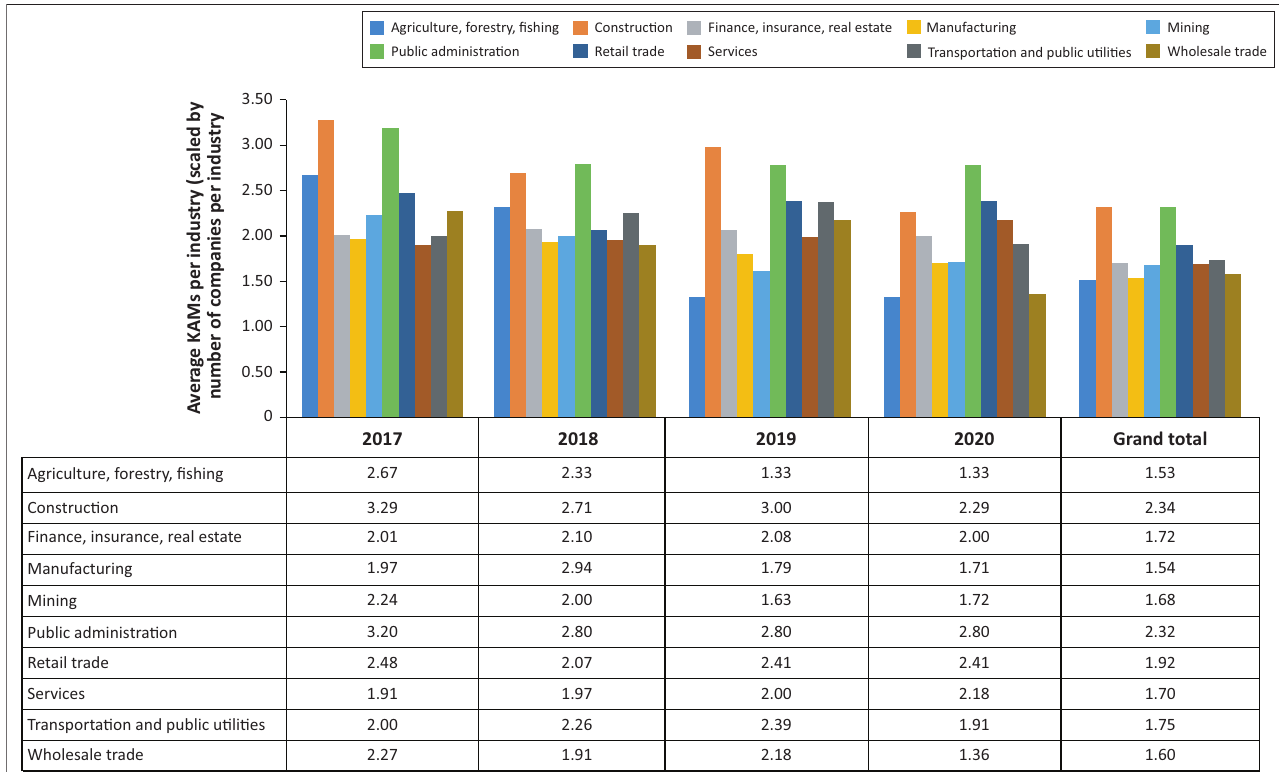
FIGURE 4: Average key audit matters per